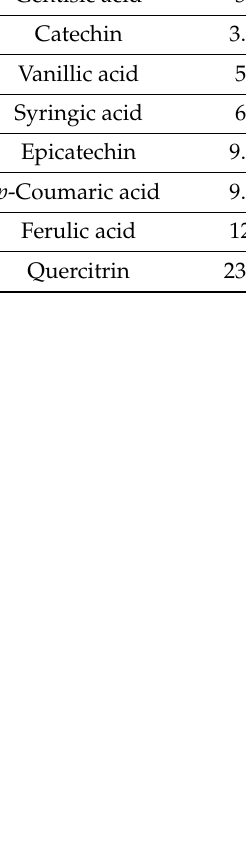
Table 2. Effect of the extracts on the rat edema induced by λ -carrageenan. Animal